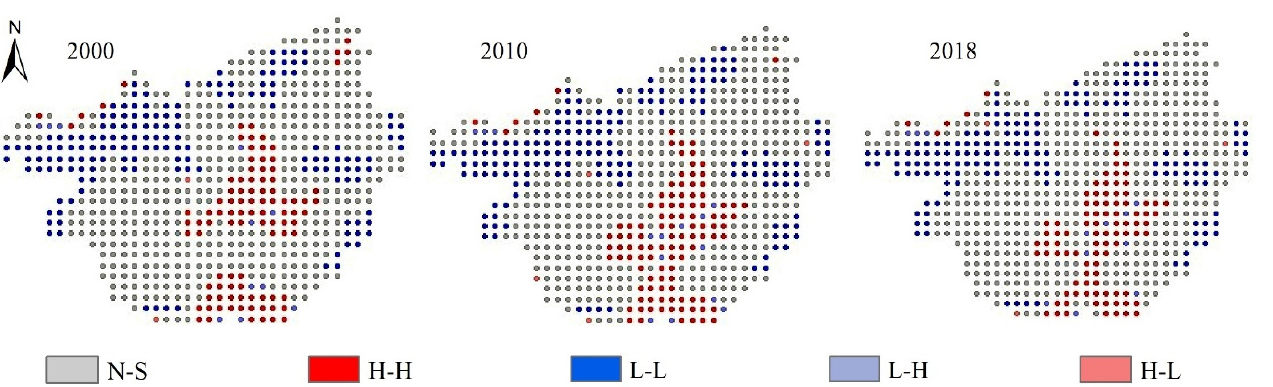
Figure 7. Global spatial autocorrelation of ecological risk in Guangxi.